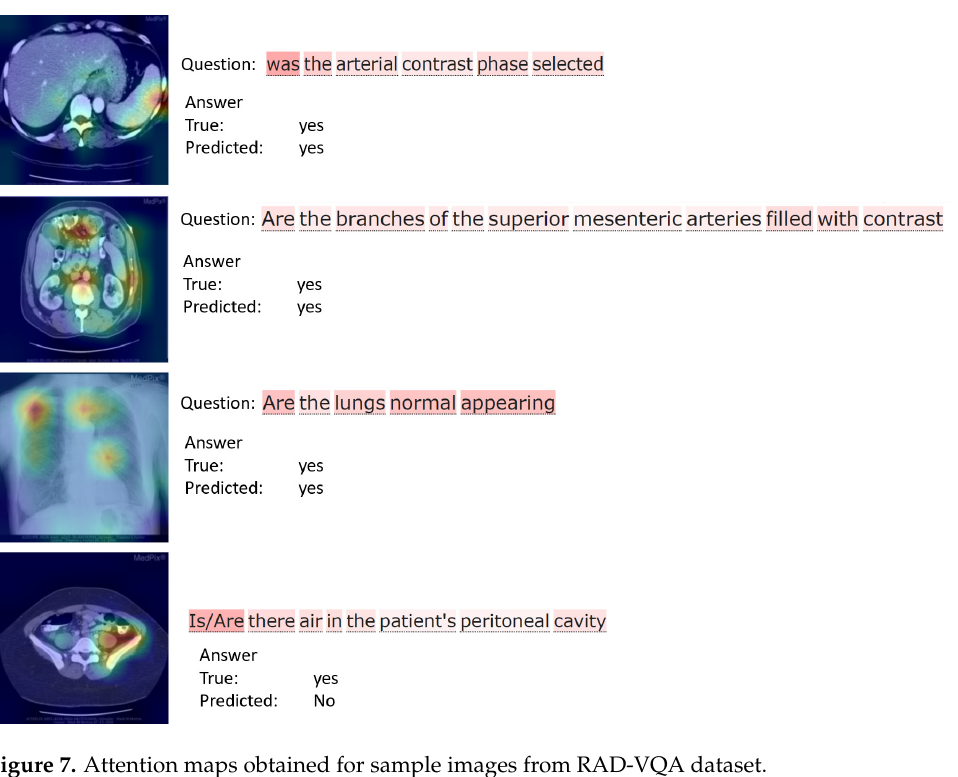
Figure 7. Attention maps obtained for sample images from RAD-VQA dataset.